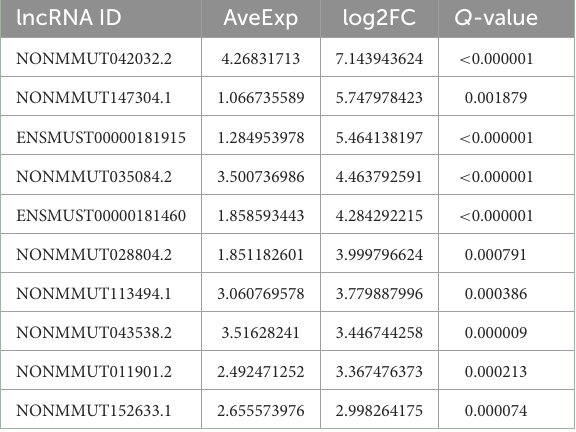
TABLE 1 Different expression levels of lncRNAs in